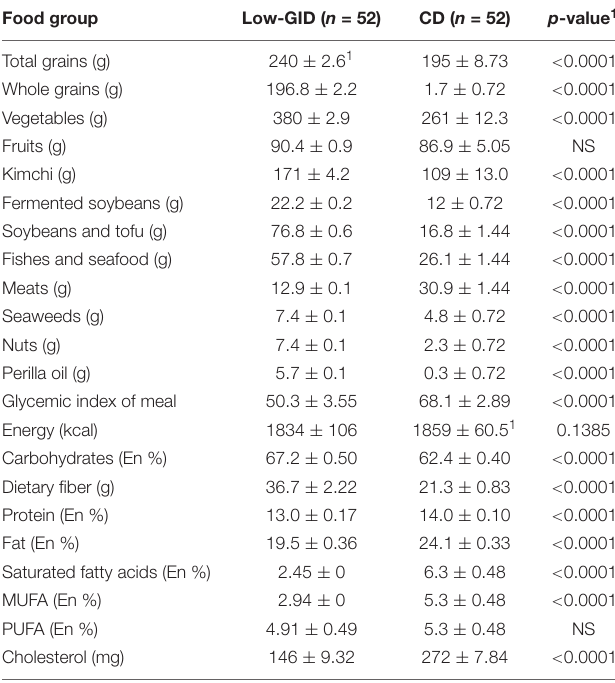
TABLE 1 | Food and nutrient intake during the